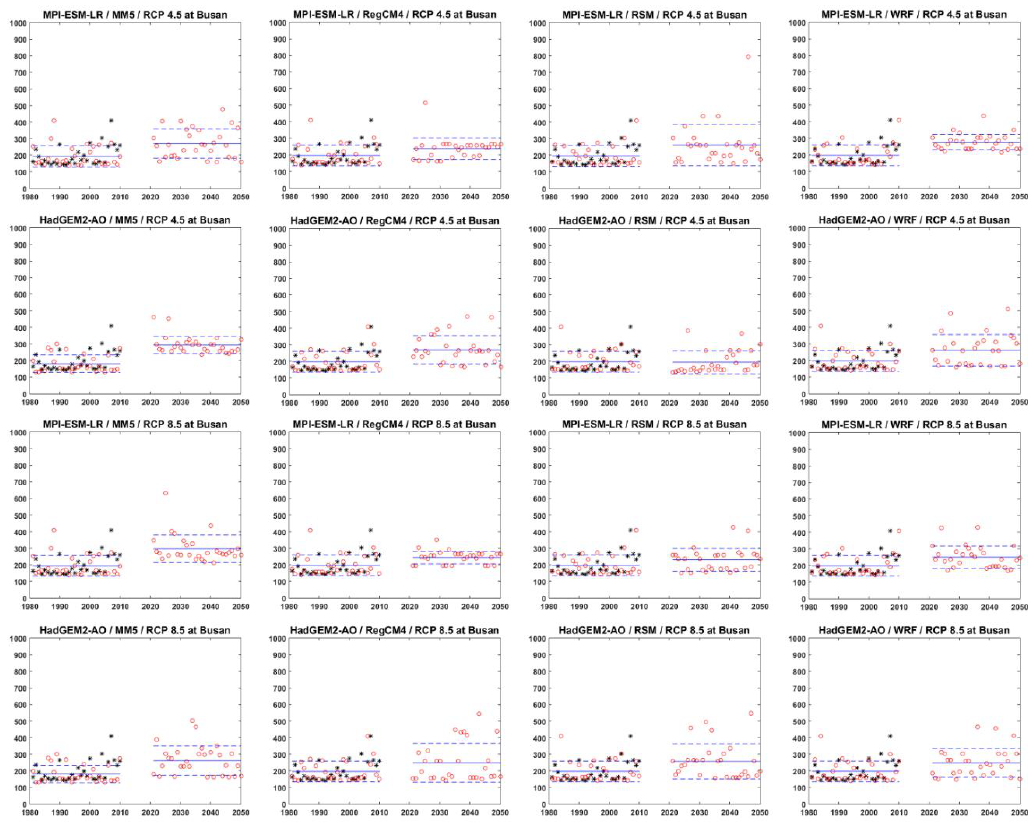
Figure 12. Annual exceedance daily rainfall depth of present and future at Busan site.